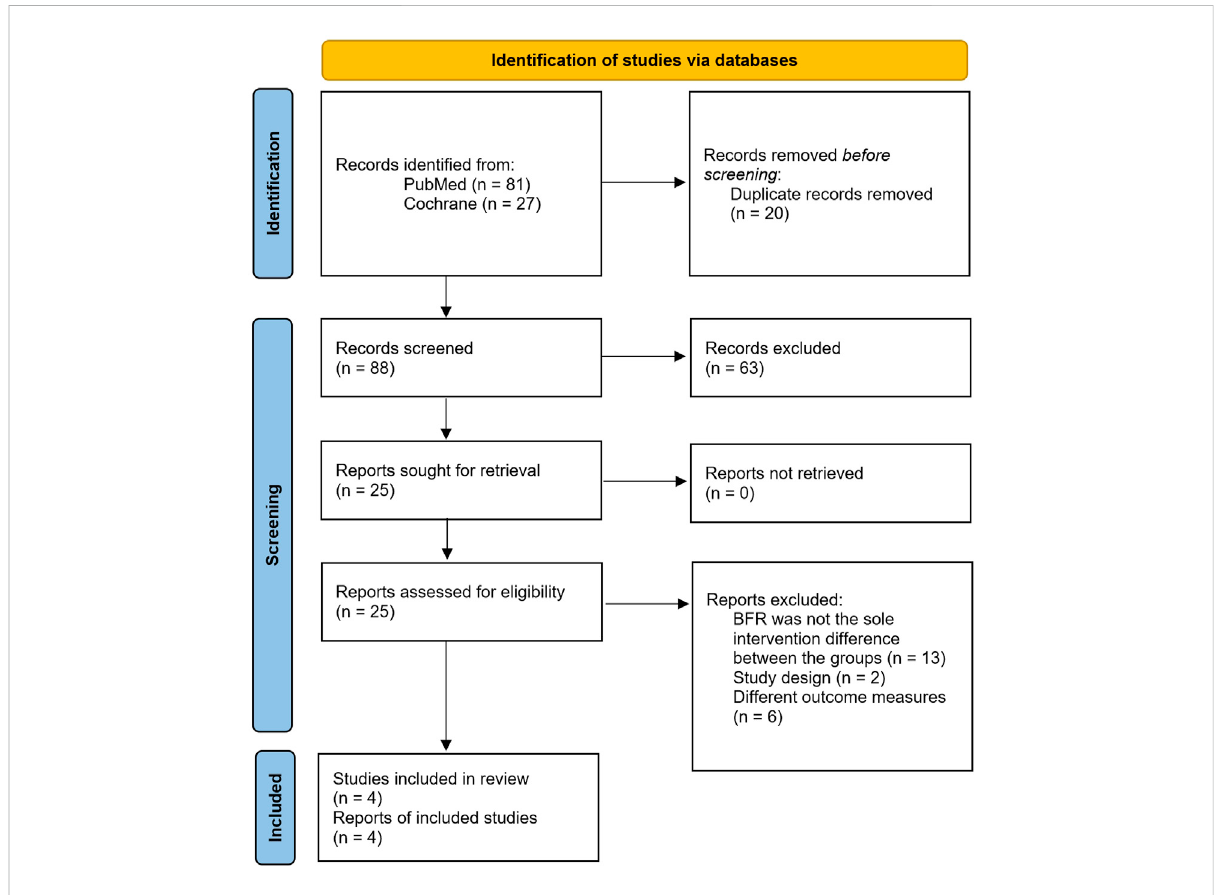
FIGURE 1 Flow diagram of study